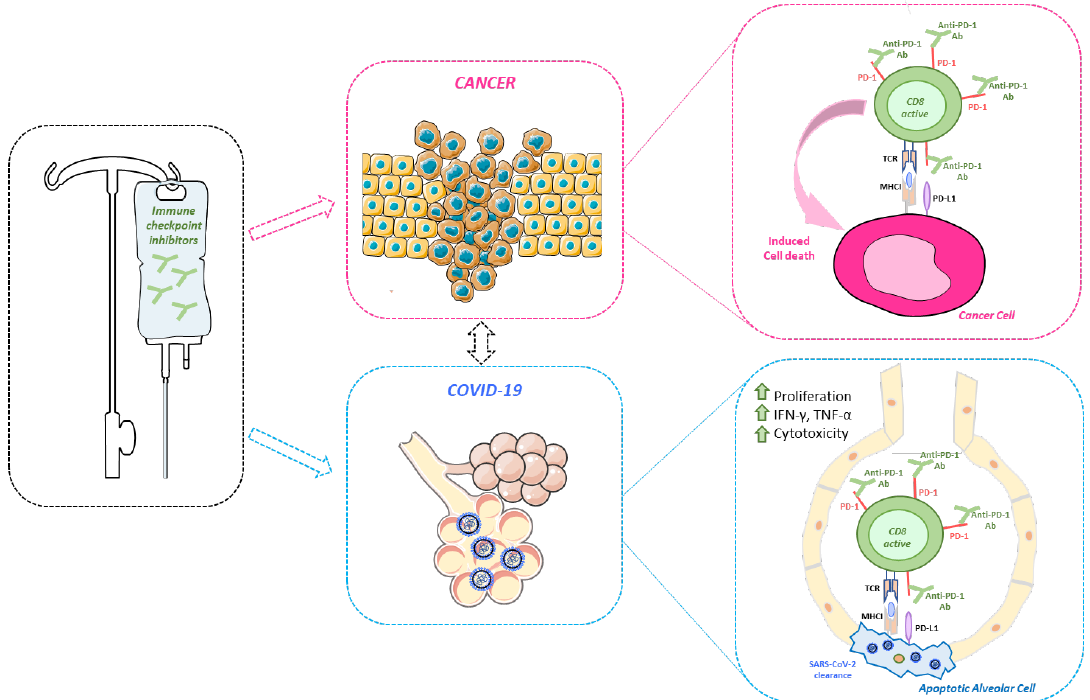
Figure 2. Effect of ICI-immunotherapy on T-cell immunity during cancer (purple boxes) and COVID-19 (light blue boxes). CD8+ T-cells, upon ICI treatment (such as anti-PD-1 antibodies) reactivate the T-cell cytotoxic response again cancer and, potentially, against severe acute respiratory syndrome associated coronavirus-2 (SARS-CoV-2) infection.